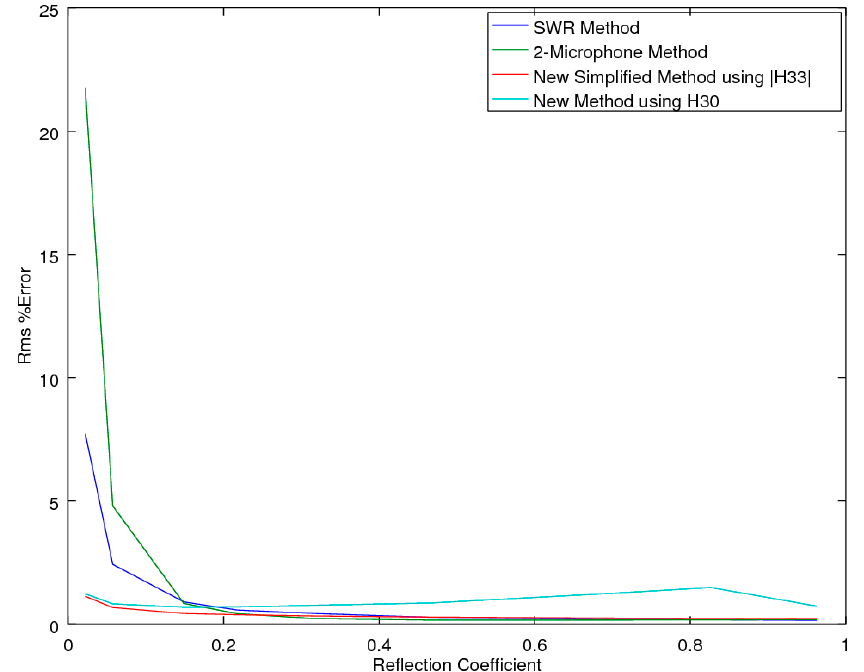
Figure 7. Comparison of accuracy from the computation of R, with a normalized noise level of 0.005 and a β value of 5.25. Comparison is between the two standard methods, SWR [2] and the two-microphone method [5,6], and the technique utilized in the three-microphone method [14], versus the new proposed methods utilizing the simplified |H 33 | method (amplitude only measurements) and the technique that uses a measurement of H 30 (complex measurements that include phase